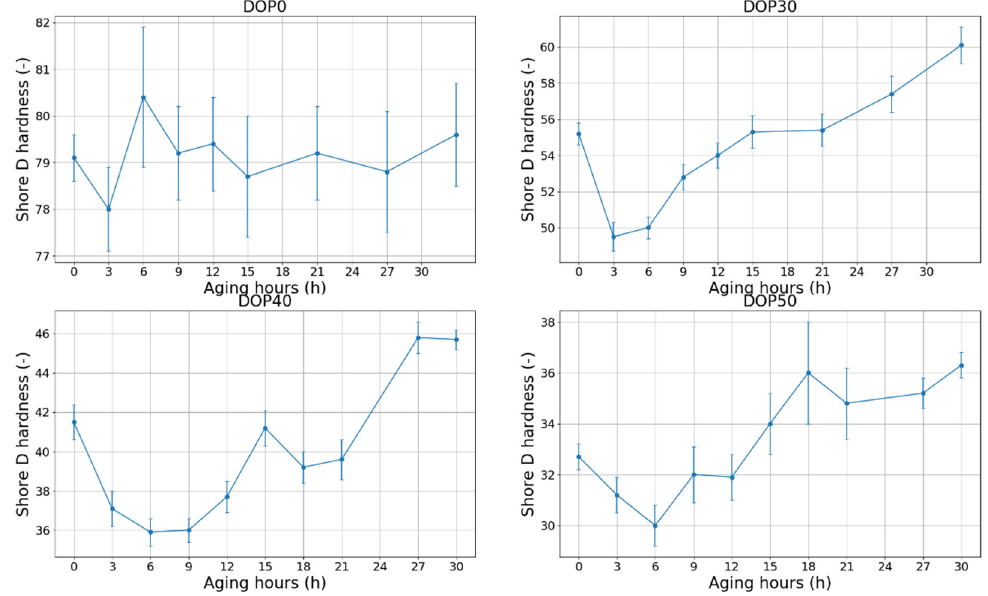
Figure 10. Changes of hardness of PVC cable samples with aging time at each temperature [27].